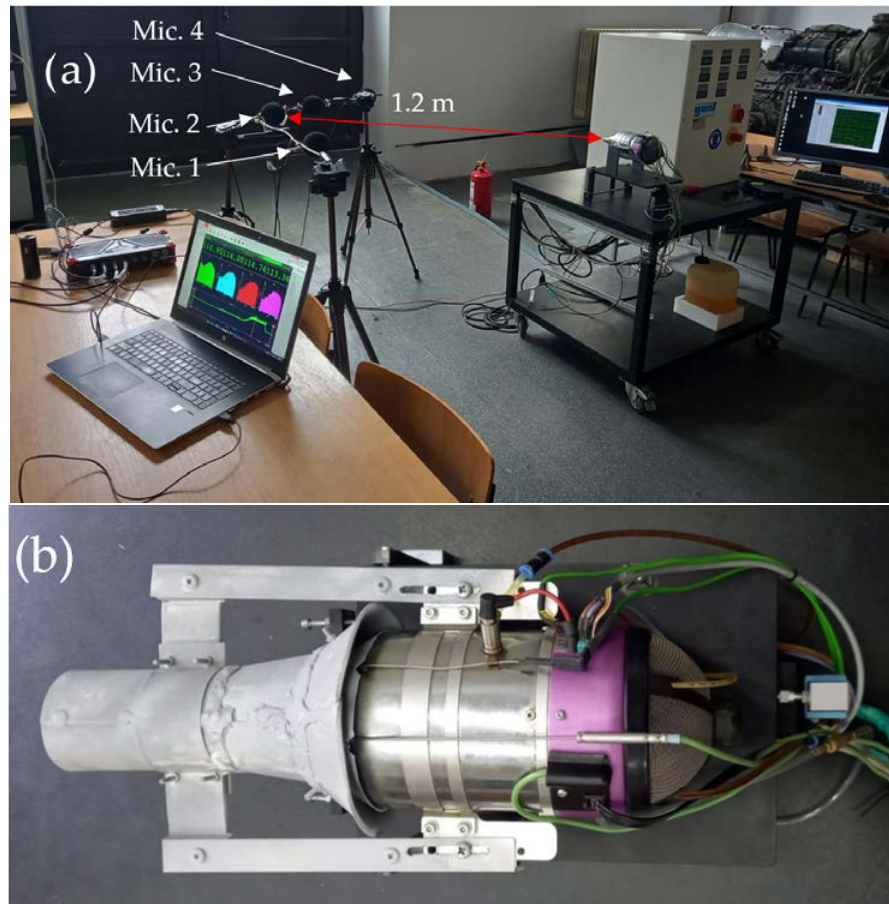
Figure 1. Test bench and instrumentation: ( a ) engine without the ejector nozzle, ( b ) engine with the ejector nozzle.